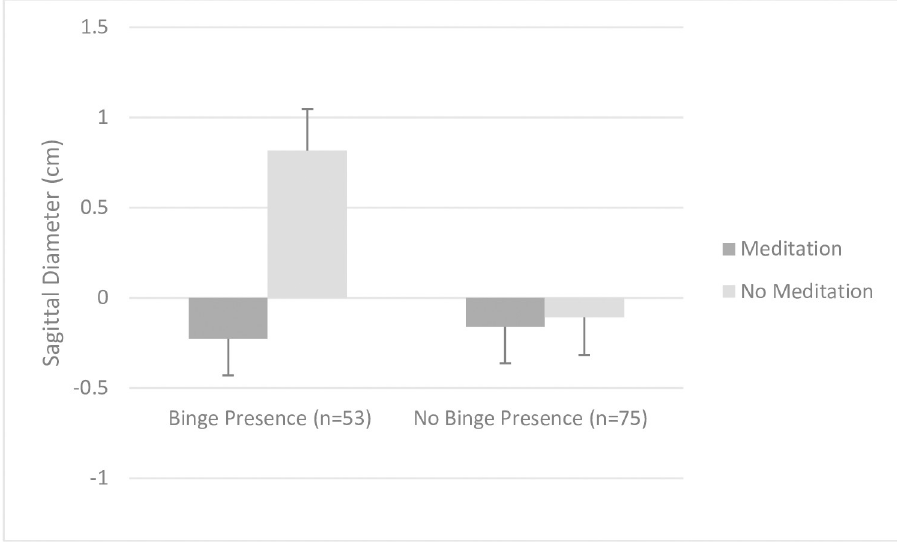
Fig 5. Associations between treatment randomization and changes in sagittal diameter at 8 weeks among those with ( n = 53) vs. without ( n = 75) baseline binge presence.